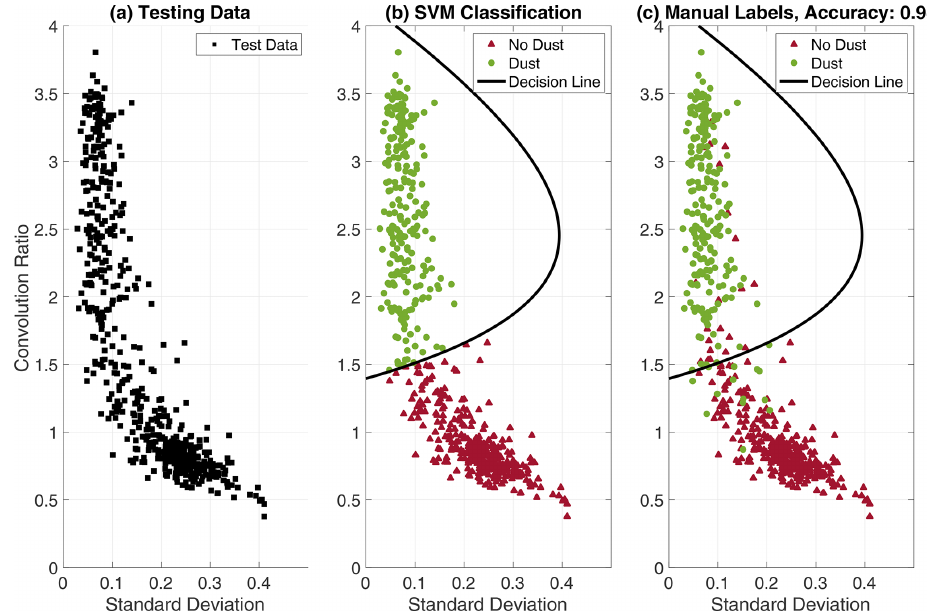
Figure 5. (a) The (1 × 2) feature vectors extracted from the testing data (600 observations with hidden labels). (b) The testing data are classified using the trained SVM decision line, where all observations within the polynomial line are classified as dust , while all observations outside are classified as no dust . (c) The “true” labels (from the manual labeling) are revealed. It is clear that some observations are confused, predominantly near the decision line. Still, the SVM classifier achieves an overall classification accuracy of 94%, calculated by comparing the outputs from the SVM classification (b) to the “true” labels (c)